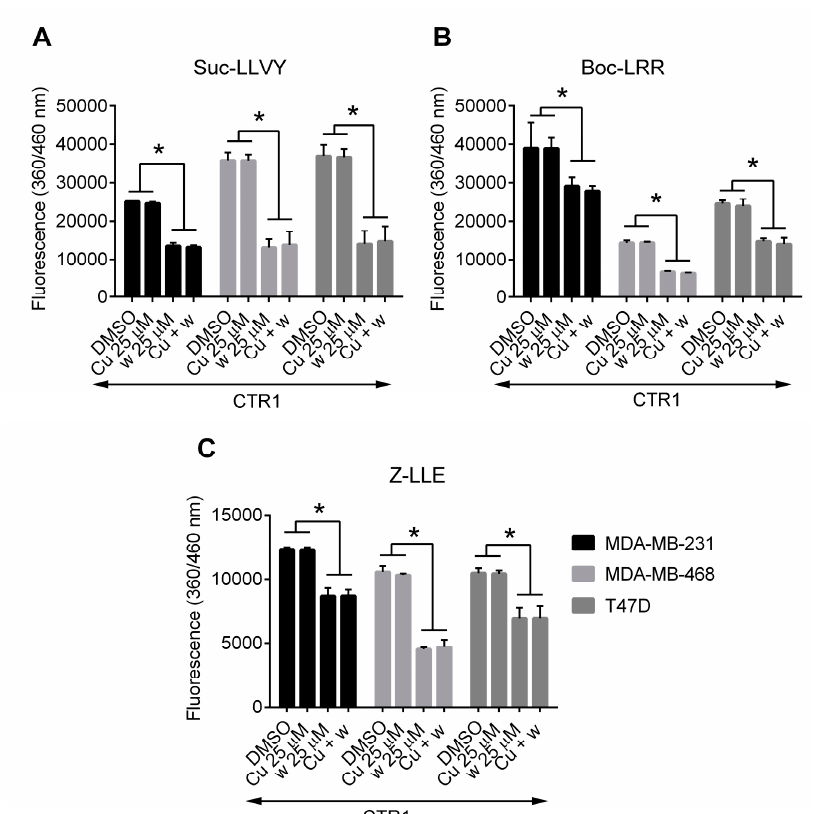
Figure 5. Copper loading does not affect inhibition of proteasome by wedelolactone . Cells were transfected with the pCNDA3.1-hCTR1-N-Myc plasmid, loaded with copper (Cu) or left untreated and exposed to various concentrations of wedelolactone (w) or solvent (DMSO) for 10 h. Proteasome activities were evaluated in cell extracts using the activity-specific fluorogenic substrates (Suc-LLVY-AMC for testing chymotrypsin-like ( A ), Z-LLE-AMC for caspase-like ( B ), and Boc-LRR-AMC for trypsin-like activities ( C )). The data represent the mean values from three independent experiments. Error bars indicate the SD. * indicates a significant ( p < 0.05) difference.